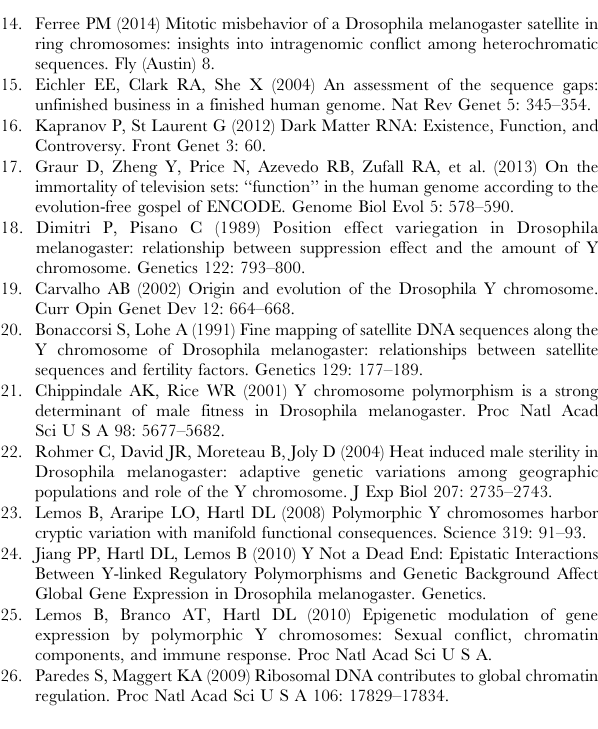
Figure S1 Melt Curve Analysis of qPCR Primer